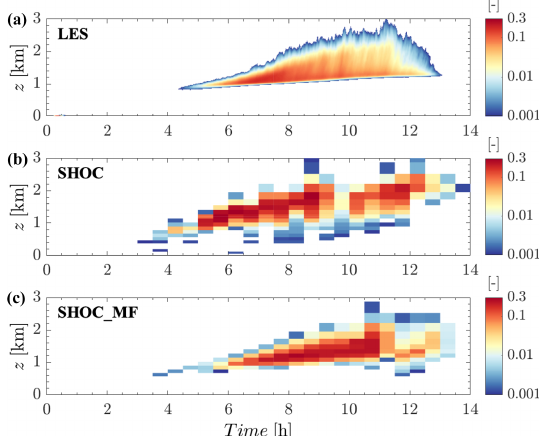
Figure 7. Time–height plot of (a) LES, (b) SHOC, and (c) SHOC + MF cloud fraction for the ARM shallow cumulus case. The LES cloud fraction corresponds to the cloud sampling defini- tion (i.e., q l > 1 × 10 − 5 kgkg − 1 ). Cloud fraction values < 0 . 001 are masked and not plotted